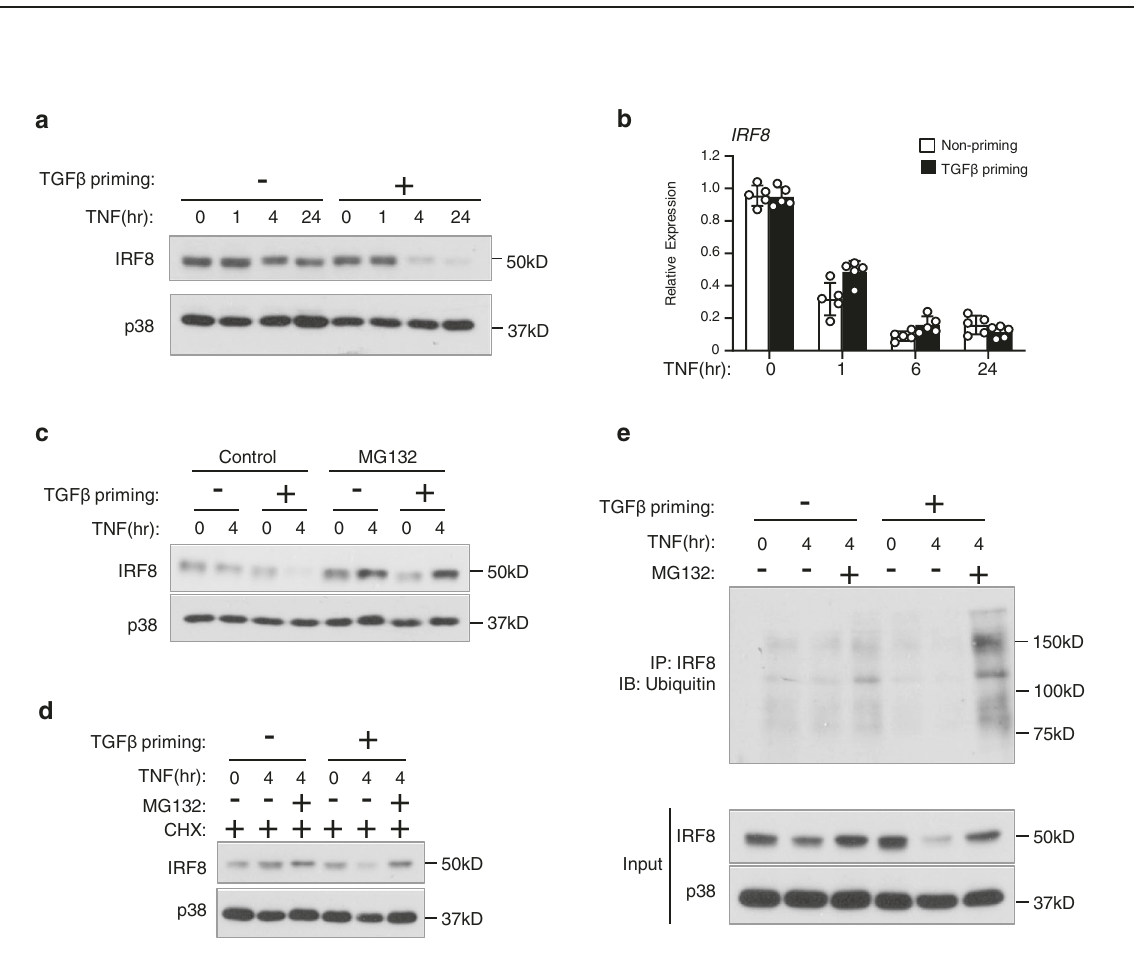
Fig. 5 TNF-induced IRF1-IFN β -ISG axis is suppressed by TGF β priming. a De novo motif-enrichment analysis of ATAC-seq peaks associated with non- priming or TGF β -priming genes. Random background regions serve as a control. b IGV track displaying normalized tag-density pro fi les for ATAC-seq, H3K4me3, H3K27me3, and H3K27ac Cut&Run-seq signals at IFNB1 locus. c qPCR analysis of mRNA expression of IFNB1 using human CD14( + )-monocytes treated with or without TGF β priming for 3 days, followed by TNF stimulation for the indicated times ( n = 5/group). d ELISA analysis of IFN β levels in the cell culture medium from TNF-induced osteoclastogenesis with or without TGF β priming ( n = 5/group). e ELISA analysis of IFN β levels in the serum from the WT and Tgfbr2 Δ M mice after TNF-induced supracalvarial osteolysis ( n = 5/group). f IGV track displaying normalized tag-density pro fi les for ATAC-seq, H3K4me3, H3K27me3, and H3K27ac Cut&Run-seq signals at IRF1 locus. g , h qPCR analysis of mRNA expression of IRF1 ( n = 5/group) ( g ) and immunoblot analysis of the expression of IRF1 ( h ) using human CD14( + )-monocytes treated with or without TGF β -priming for 3 days, followed by TNF stimulation for the indicated times. p38 was used as a loading control. i Immunoblot analysis of the expression of IRF1 using human CD14( + )-monocytes treated with or without TGF β -priming for 3 days, followed by TNF or RANKL stimulation for 4 hr. p38 was used as a loading control. j Osteoclast differentiation was determined by TRAP staining (left) and the relative area of TRAP-positive-MNCs/well (right) in the cell cultures, in which the bone marrow of WT and Irf1 − / − mice was primed with or without TGF β for 4 days, followed by TNF stimulation for two days. TRAP-positive cells: red. ( n = 5/group). k – l qPCR analysis of mRNA expression of the indicated osteoclast genes ( k ) and ISGs ( l ) during osteoclastogenesis using the WT and Irf1 − / − cells with or without TGF β -priming followed by TNF stimulation for the indicated times ( n = 5/group). c , d , e , g , j , k , l ** p < 0.01; *** p < 0.001; **** p < 0.0001; ns, not statistically signi fi cant by two-way ANOVA with Bonferroni ’ s multiple comparisons test. Error bars: c , d , e , g , j , k , l Data are mean ± SD. j 200 µ m. Source data are